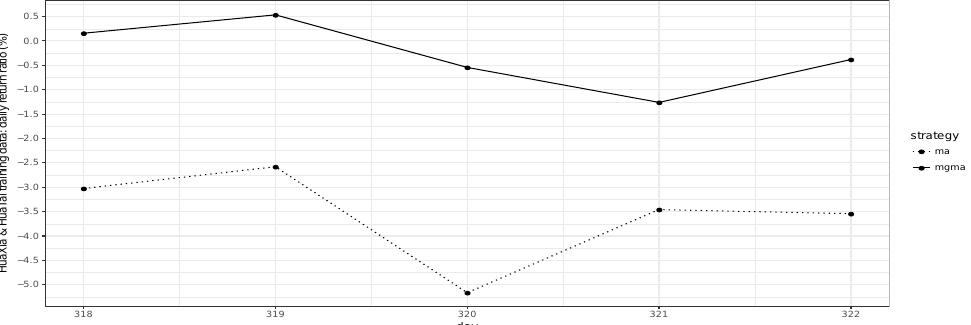
Figure 5. Case 2—MGMA strategy performance summary plot for HuaXia ETF and HuaTai ETF on